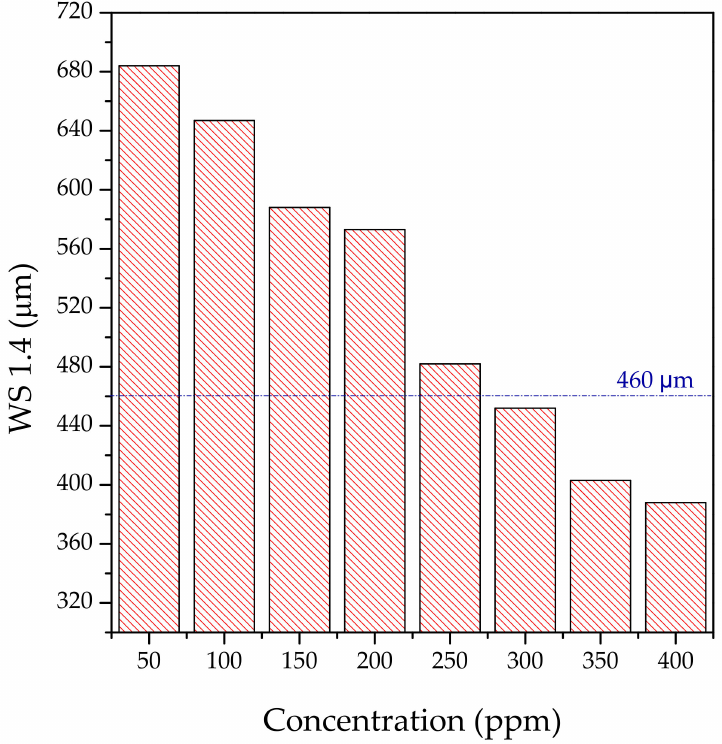
Figure 3. Impact of soybean oil N , N -Bis(2-ethoxyethyl) amides addition on the lubrication character- istics of the base